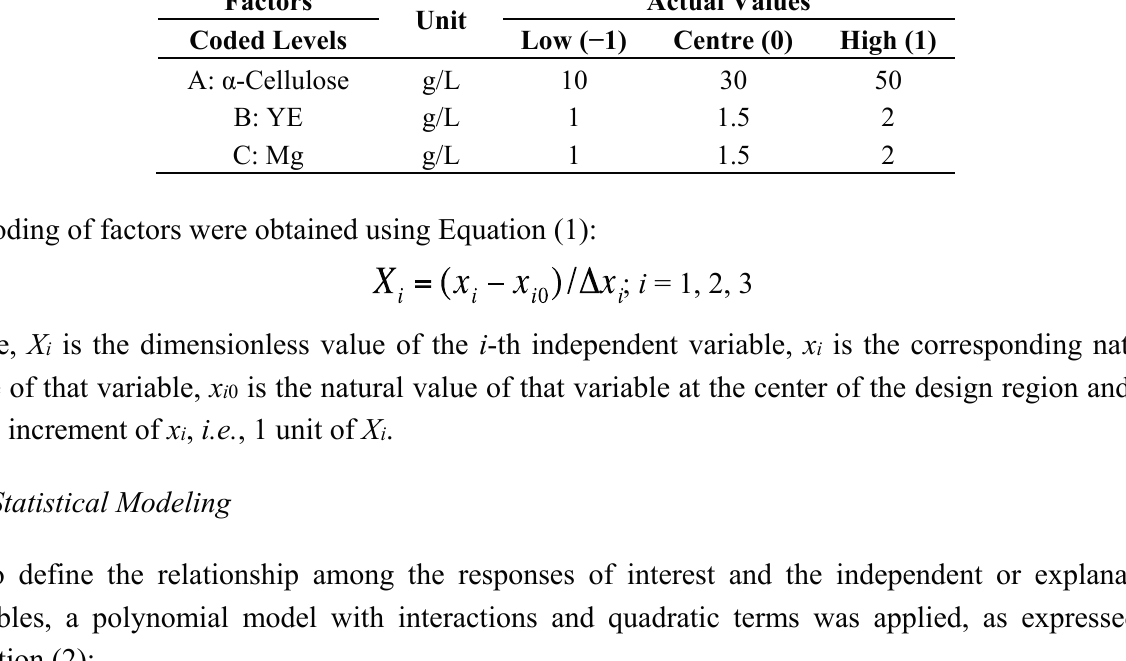
Table 9. Actual values and coded levels of factors used in the central composite face-centered (CCF) design. Factors Actual Values Unit Coded Levels Low ( − 1) Centre